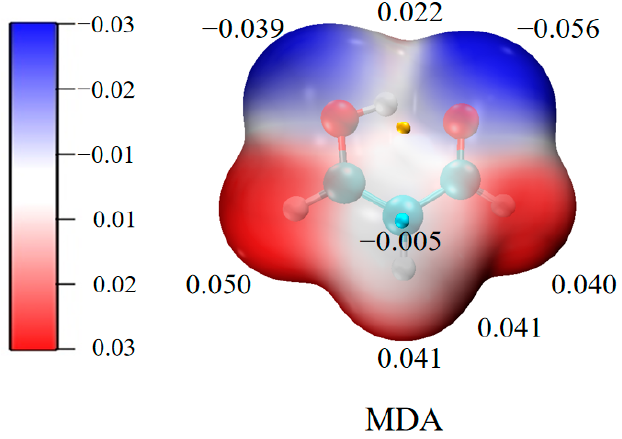
Figure 1. MEP maps of MDA. All are in a.u.